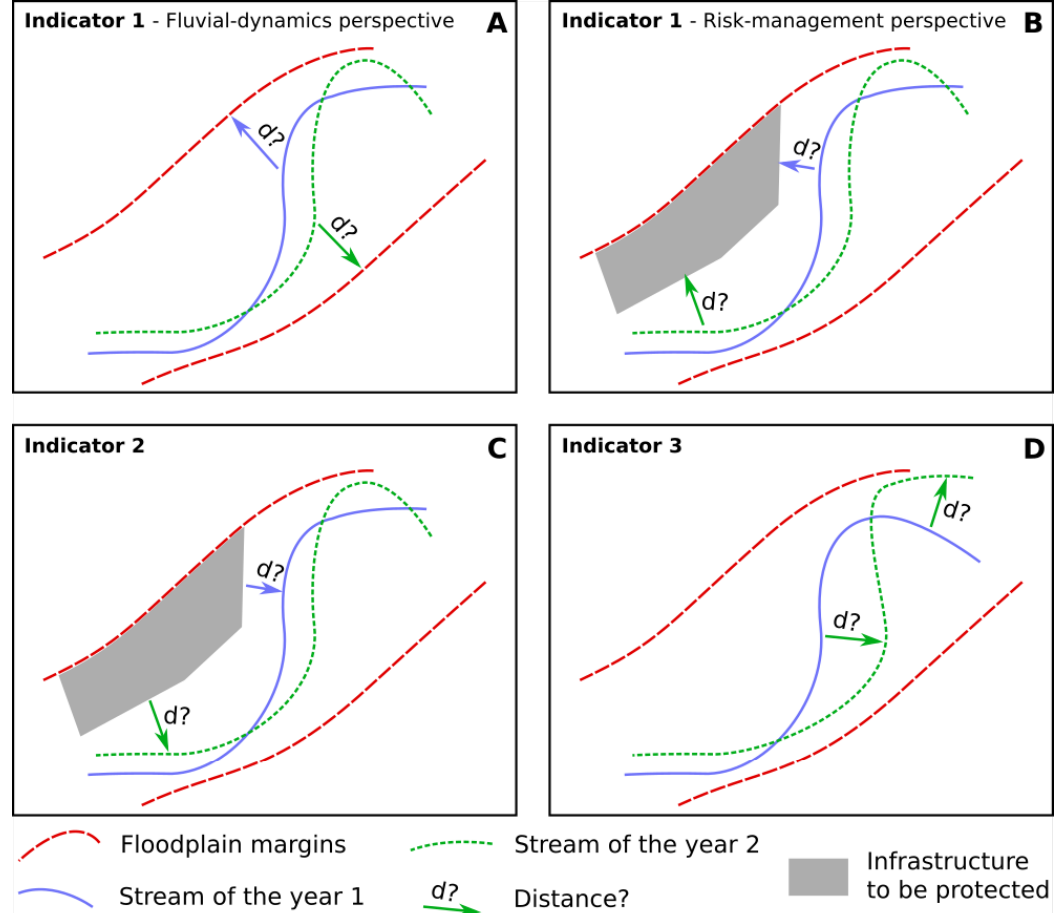
Figure 4. The three proposed indicators. Indicator 1 in a perspective of fluvial dynamics study is the distance from active channel to floodplain margins ( A ); indicator 1 in a perspective of risk management is the distance from active channel to the edges of the stake ( B ); indicator 2 is the distance from the stake to the active channel ( C ); indicator 3 is the diachronic distance ( D ).